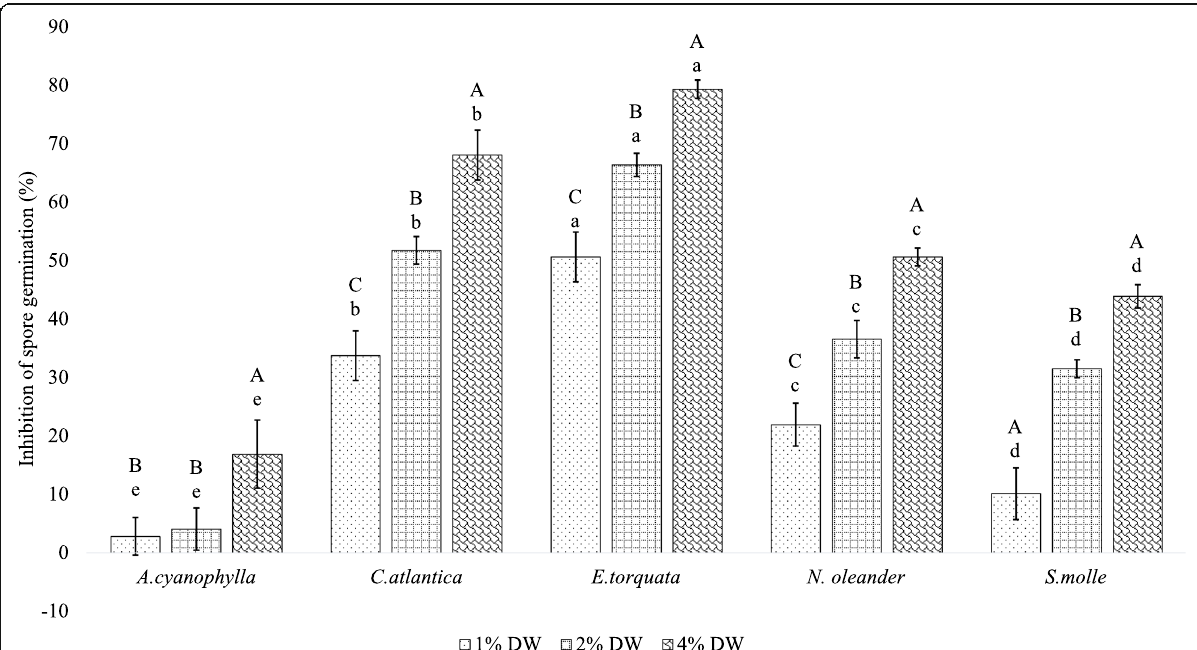
Fig. 2 Effect of different plant DW percentage on Foa spore germination. Plant species and extract concentration had significant effects on the percentage of inhibition of spore germination (one-way ANOVA, p < 0.05). Each bar represents the mean of five replicate plates per concentration. Within each plant species, bars followed by the same uppercase letters, indicate no significant differences among extract concentrations, while within each concentration; bars followed by the same lowercase letters indicate no significant differences among plant species (Bonferroni tests, p < 0.05). Error bars represent standard